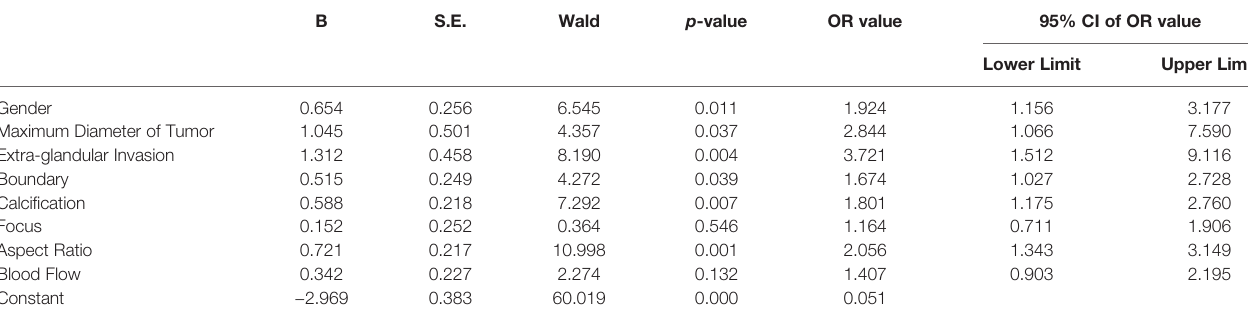
TABLE 2 | Independent risk factors for